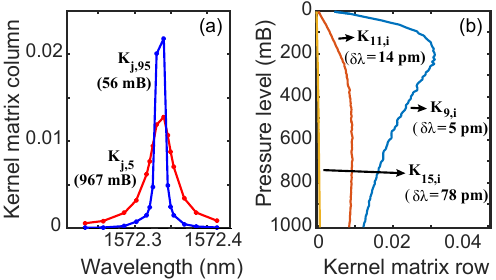
Figure 2. Forward-model K matrix: (a) we illustrate the K matrix by plotting two columns, each corresponding to the absorption due to a certain slice of the atmosphere. With increasing atmospheric pressure, the absorption lineshape is pressure-broadened. (b) We plot three rows of K , each showing the dependence of the absorption to different parts of the atmosphere for a given measurement wave- length sample. The sample wavelength corresponding to each row has been expressed as a deviation from the absorption line center 1572.335122nm. The absorption is lower the further one deviates from the absorption line